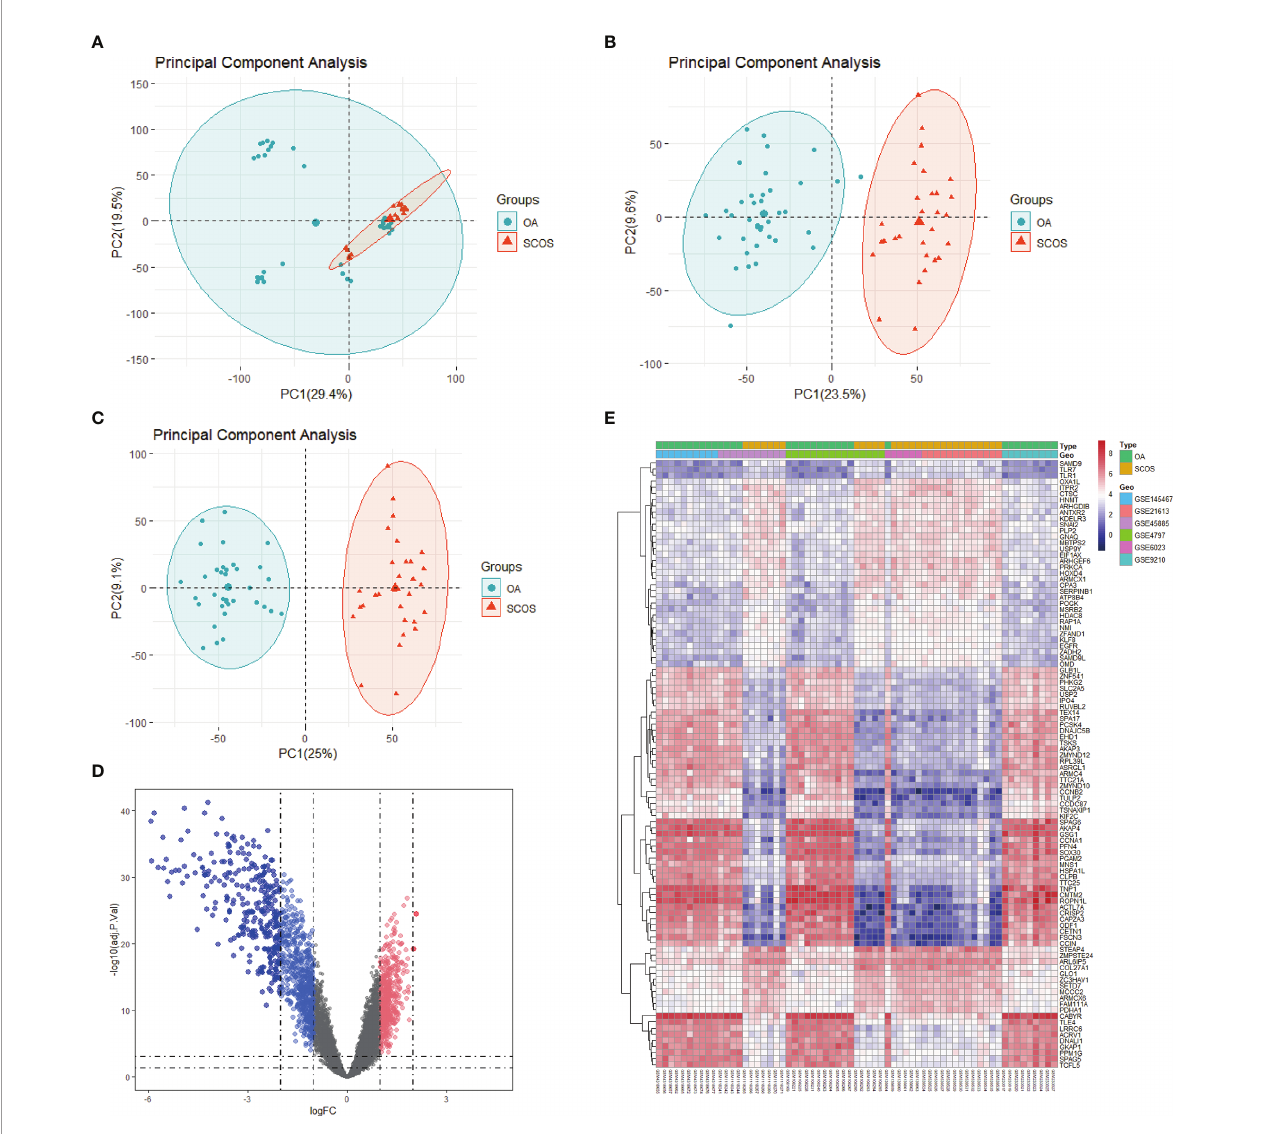
FIGURE 2 | Data pre-processing and DEGs identi fi cation. Principal component analysis (PCA) depicting the whole pro fi le of the six datasets (A) prior to and (B) after batch correction and data fusion. (C) PCA after outlier removal. (D) A volcano plot depicting the distribution of DEGs between SCOS and OA samples from the six datasets. Red, blue, and gray dots represent gene expression levels corresponding to upregulated, downregulated, and insigni fi cant expression. (E) A heatmap depicting the top 50 upregulated and top 50 downregulated DEGs. Red and blue dots represent gene expression levels corresponding to upregulated and downregulated expression. DEGs: differentially expressed genes; OA, obstructive azoospermia; SCOS, Sertoli cell-only